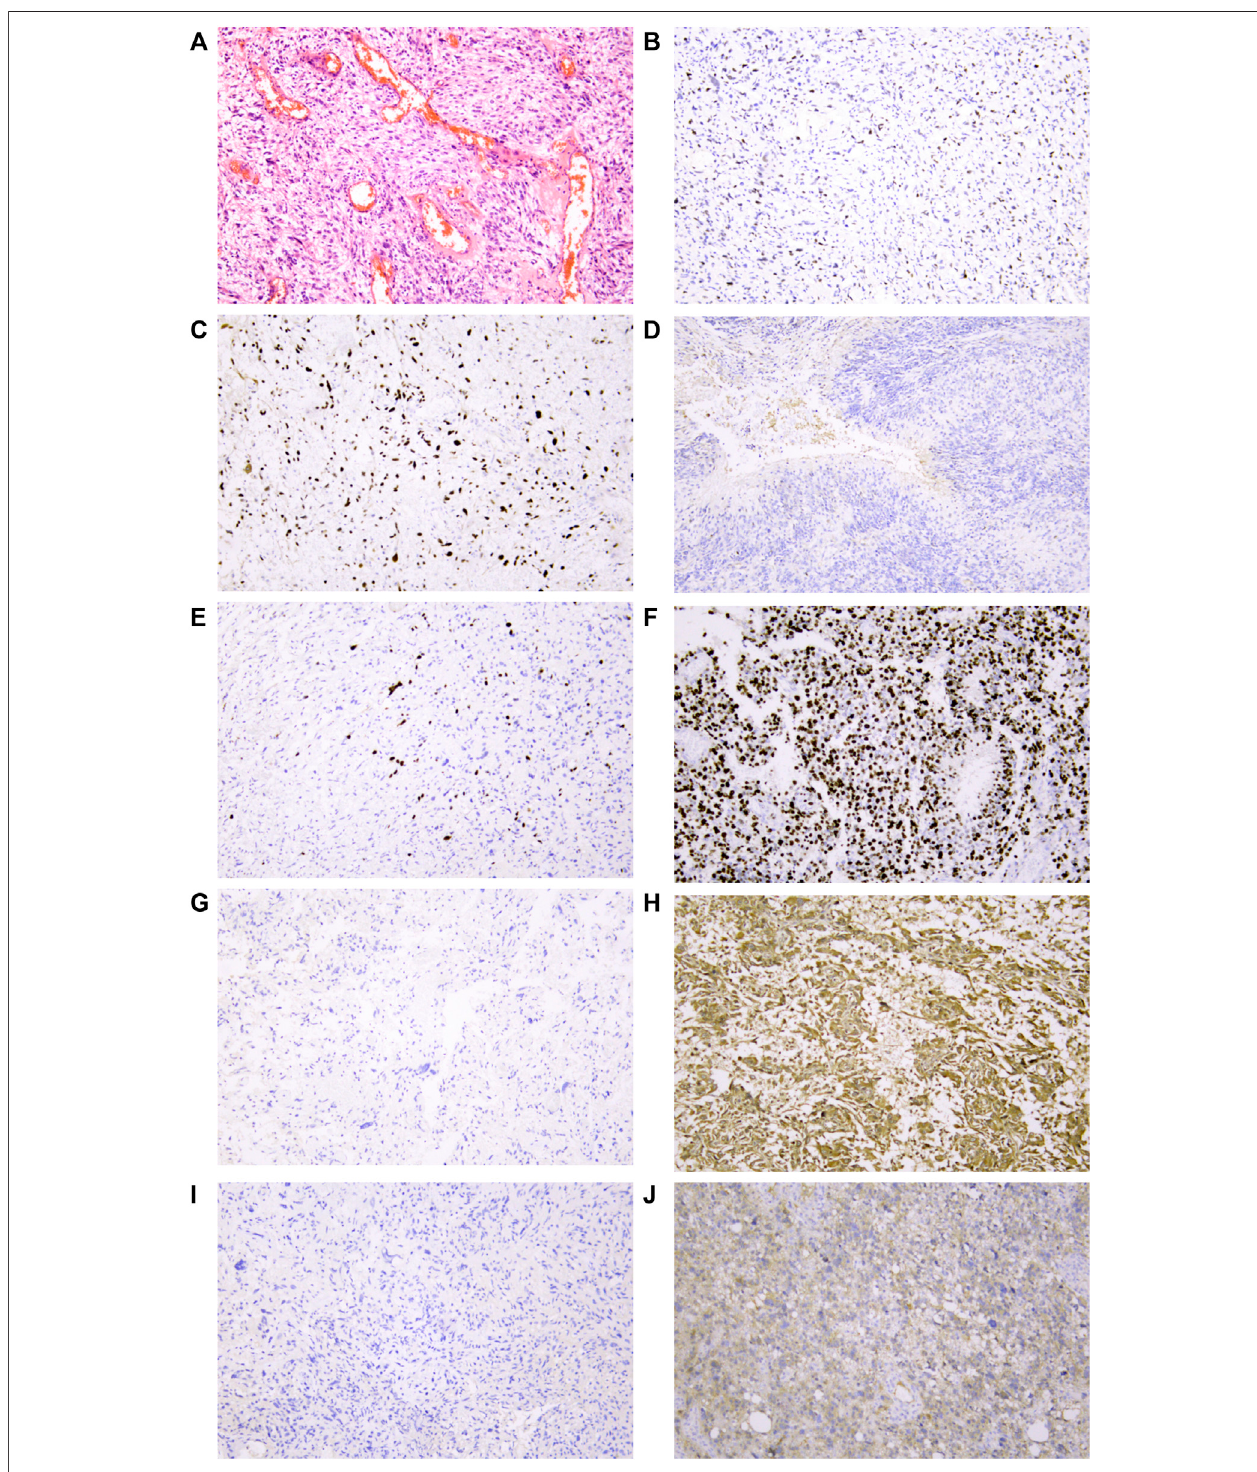
FIGURE 6 | Representative IHC analyses of p53/Ki-67/MGMT/IDH1R132H protein expression in cancer cells of glioblastoma patients. (A) Representative glioblastoma with HE staining. (B) Normal/wild-type p53 protein expression pattern with partly and weakly positive expression in tumor nuclei. Two patterns were identi fi ed as abnormal/mutant-staining pattern. (C) Abnormal overexpression of p53 protein with strong staining in nearly all tumor nuclei compared to internal control central fi broblasts. (D) . Abnormal complete absence of p53 staining with suf fi cient staining of internal controls ( fi broblasts, endothelial cells, or lymphocytes). (E) LowproportionofKi-67proteinexpressionintumornucleisuggestedthatthetumorhaslowproliferativeactivity. (F) HighproportionofKi-67proteinexpressionintumor